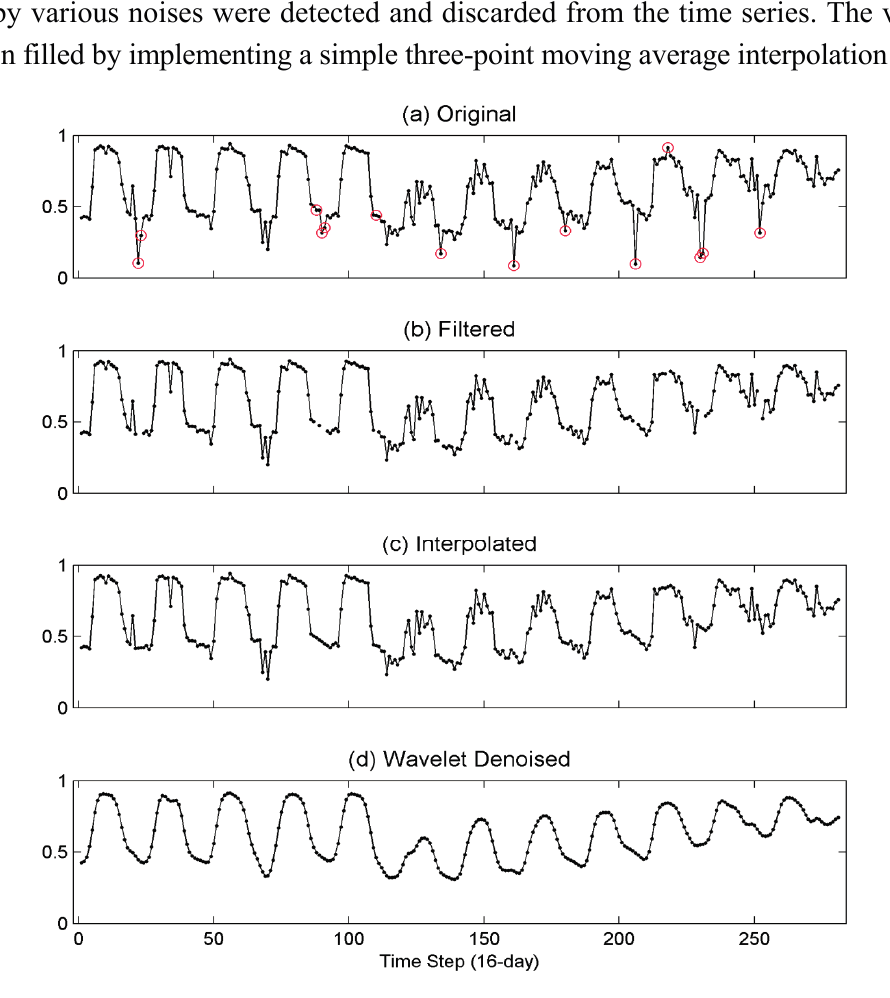
Figure 3. Pre-processing procedures implemented on a NDVI time series: ( a ) original time series (the red circles mark the time points that are filtered based on QA data); ( b ) time series retained after filtering based on QA data; ( c ) time series with linear interpolation on filtered points; and ( d ) time series attained after wavelet